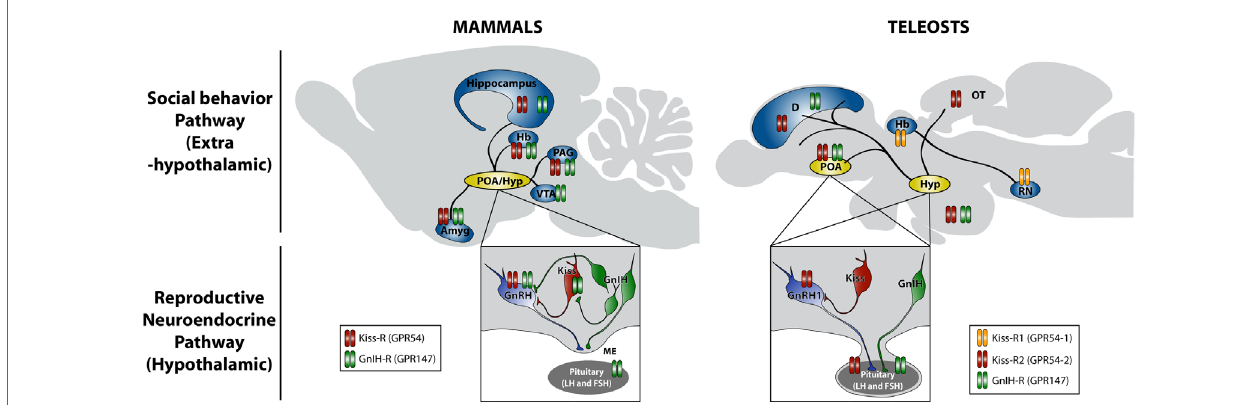
FiGUre 1 | schematic model of actions of kisspeptin and GniH in the regulation of social behavior in mammals and teleosts . Neuronal cell bodies producing gonadotropin-releasing hormone (GnRH), kisspeptin (Kiss), and gonadotropin-inhibitory hormone (GnIH) are located in the preoptic area (POA) and hypothalamic (Hyp) region. GnRH is secreted at the median eminence (ME) in mammals, whereas GnRH1 is directly secreted in the pituitary in teleosts, and they regulate gonadotropin (LH and FSH) synthesis and release from the pituitary gland, which stimulates sex steroid synthesis and gametogenesis in the gonads. Sex steroids feedback to the brain and construct neuronal architecture and modulate the activity of neurons, which regulate the expression of social behavior, such as courtship, mating, and aggression. Kiss neurons stimulate GnRH and GnRH1 release in mammals and teleosts, respectively. GnIH neurons inhibit the activity of GnRH and Kiss neurons as well as pituitary gonadotropin secretion in mammals. On the other hand, GnIH neurons terminate in the pituitary in teleosts. In addition to this reproductive neuroendocrine (hypothalamic) pathway, neuronal fibers containing Kiss and GnIH are found in extrahypothalamic regions, such as amygdala (Amyg), hippocampus, habenula (Hb), periaqueductal gray (PAG), and ventral tegmental area (VTA) in mammals and also dorsal telencephalic area (D), optic tectum (OT), and raphe nuclei (RN) in teleosts, which can directly regulate social behavior by acting within the brain (social behavior pathway). Neuronal fiber distributions of Kiss and GnIH neurons as well as locations of kisspeptin receptor (Kiss-R: GPR54) and GnIH receptor (GnIH-R: GPR147) in mammals are based on Tena-Sempere (84), Lehman et al. (85), Tsutsui and Ubuka (86), and Ubuka et al. (74). Neuronal fiber distributions of Kiss and GnIH neurons as well as locations of kisspeptin receptor (Kiss-R1: GPR54-1 and Kiss-R2: GPR54-2) and GnIH receptor (GnIH-R: GPR147) in teleosts are based on Escobar et al. (87), Qi et al. (88), Nathan et al. (73), Parhar et al. (89), and Grone et al.